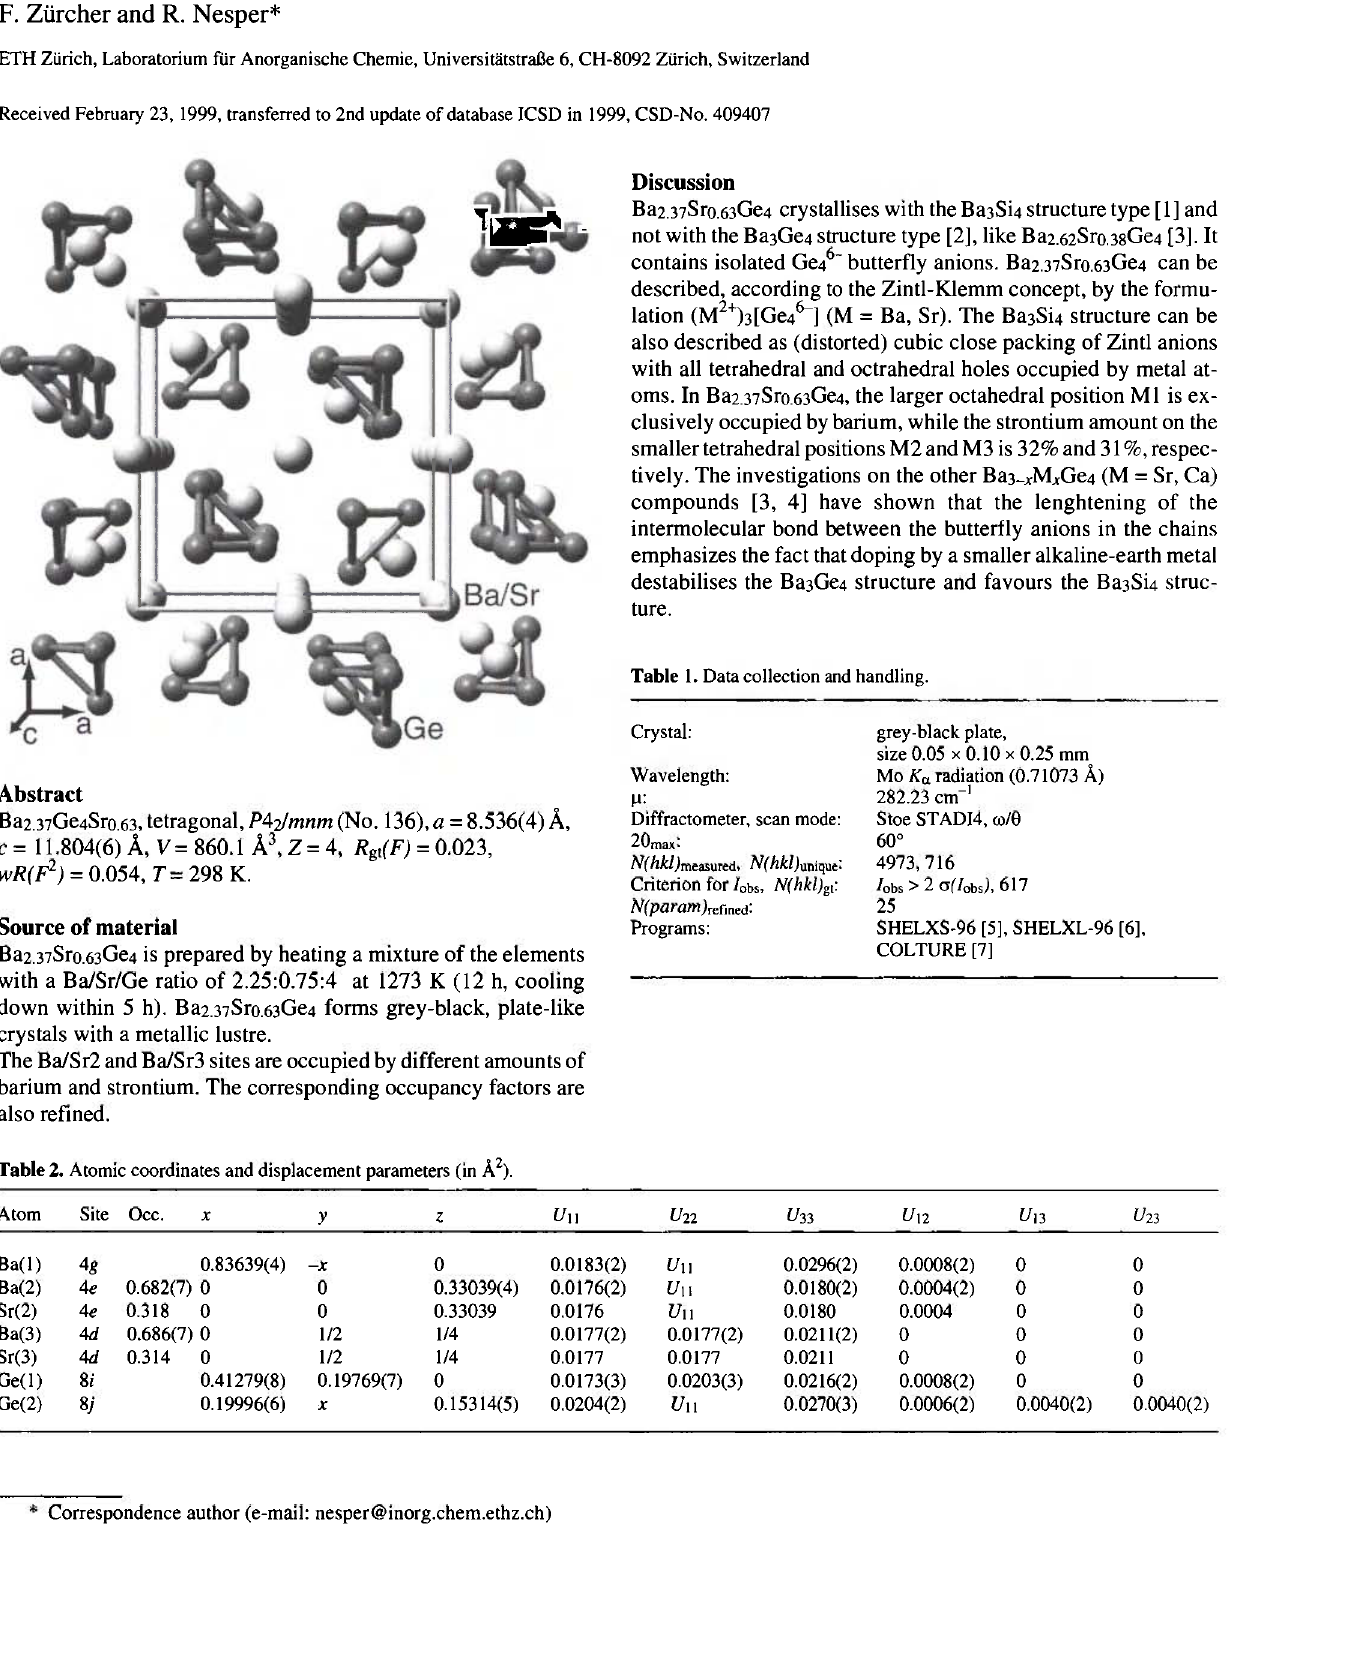
Table 2. Atomic coordinates and displacement parameters (in A 2 ).